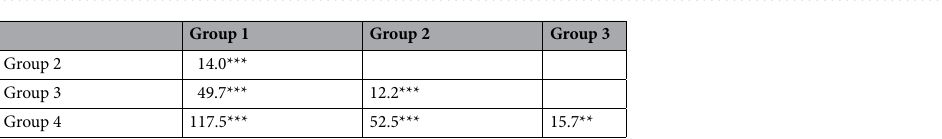
Figure 2. Clustering of 110 sweet sorghum accessions into 4 groups using the standardized squared Euclidean distance of Ward’s hierarchical clustering method.